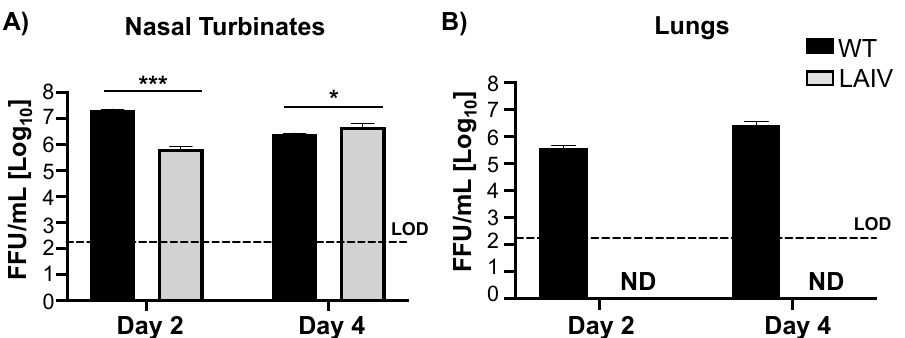
Figure 4. B/Brisbane/60/2008 MDV LAIV replication in vivo: C57BL/6J 6-weeks-old female mice ( n = 3) were infected intranasally with 10 6 FFU of B/Brisbane/60/2008 WT (black) or MDV LAIV (grey). Nasal turbinates ( A ) and lungs ( B ) were collected at days 2 and day 4 post-infection and viral titers were determined by immunofocus assay (FFU/mL). Dotted lines indicate the LOD of the assay (200 FFU). Data is represented as the mean and SD. Student t test was performed to determine p values. *, p < 0.05; ***, p < 0.001. ND = Not detected.